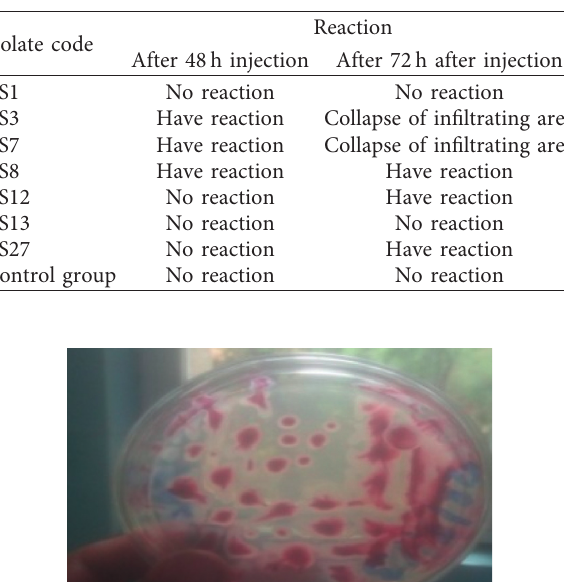
Table 1: Hypersensitivity reaction of Pelargonium zonale leaves node to infiltration with isolates of R. solanacearum .